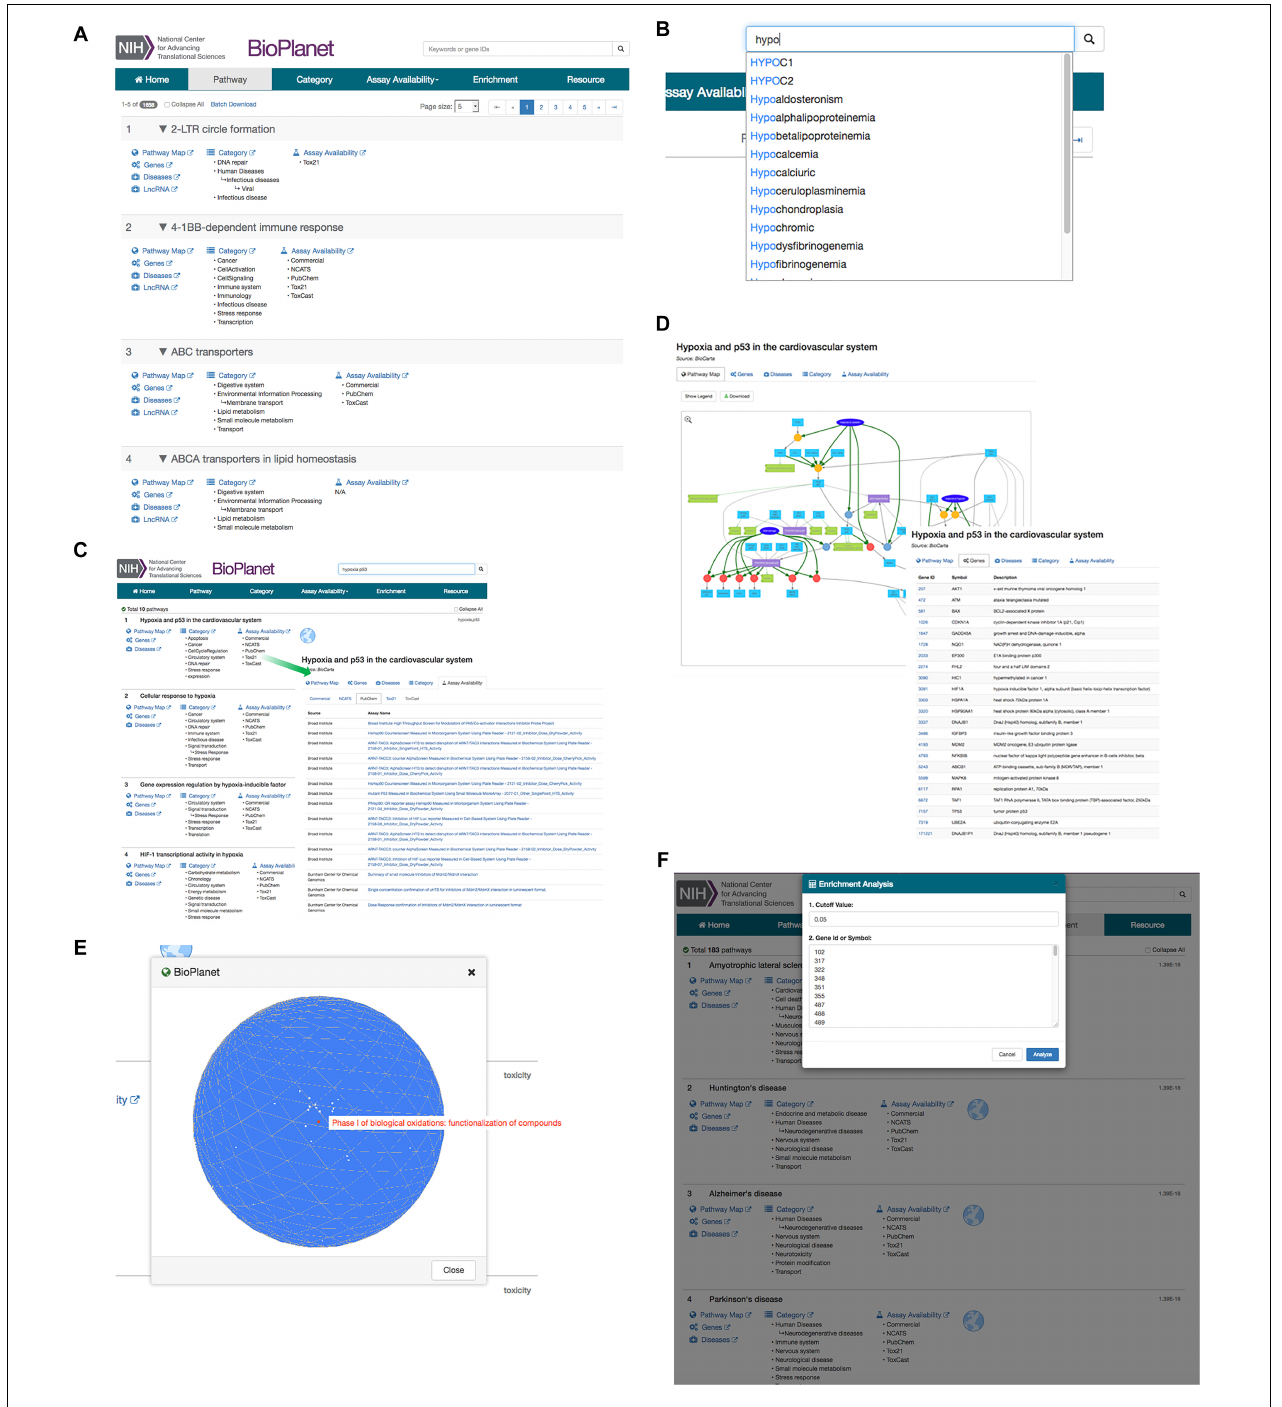
FIGURE 5 | Example use cases of the NCATS BioPlanet web browser (http://tripod.nih.gov/bioplanet). (A) Pathway browsing by name, category, or assay availability from main page. (B) Free text search with the autosuggest functionality. (C) Search results view: a multiple term search example with the keywords “hypoxia” and “p53.” The term(s) used to retrieve each pathway, “hypoxia” and/or “p53,” is shown on the right. The pathway title, when clicked on, expands to show detailed annotations such as assay availability, category, disease relevance, with links to outside sources when available. This example shows the assays available in PubChem for the first pathway retrieved. (D) Pathway detail view with an interactive pathway diagram and its gene component list. (E) The 3-dimensional globe view that shows a group of pathways projected on the globe. Each dot on the globe represents a pathway. Mousing over the pathway shows the pathway name. (F) Enrichment analysis tool that allows users to paste in a list of genes and determine which BioPlanet pathways are enriched in the gene list. The significance of enrichment p -value is shown on the right of each pathway returned.